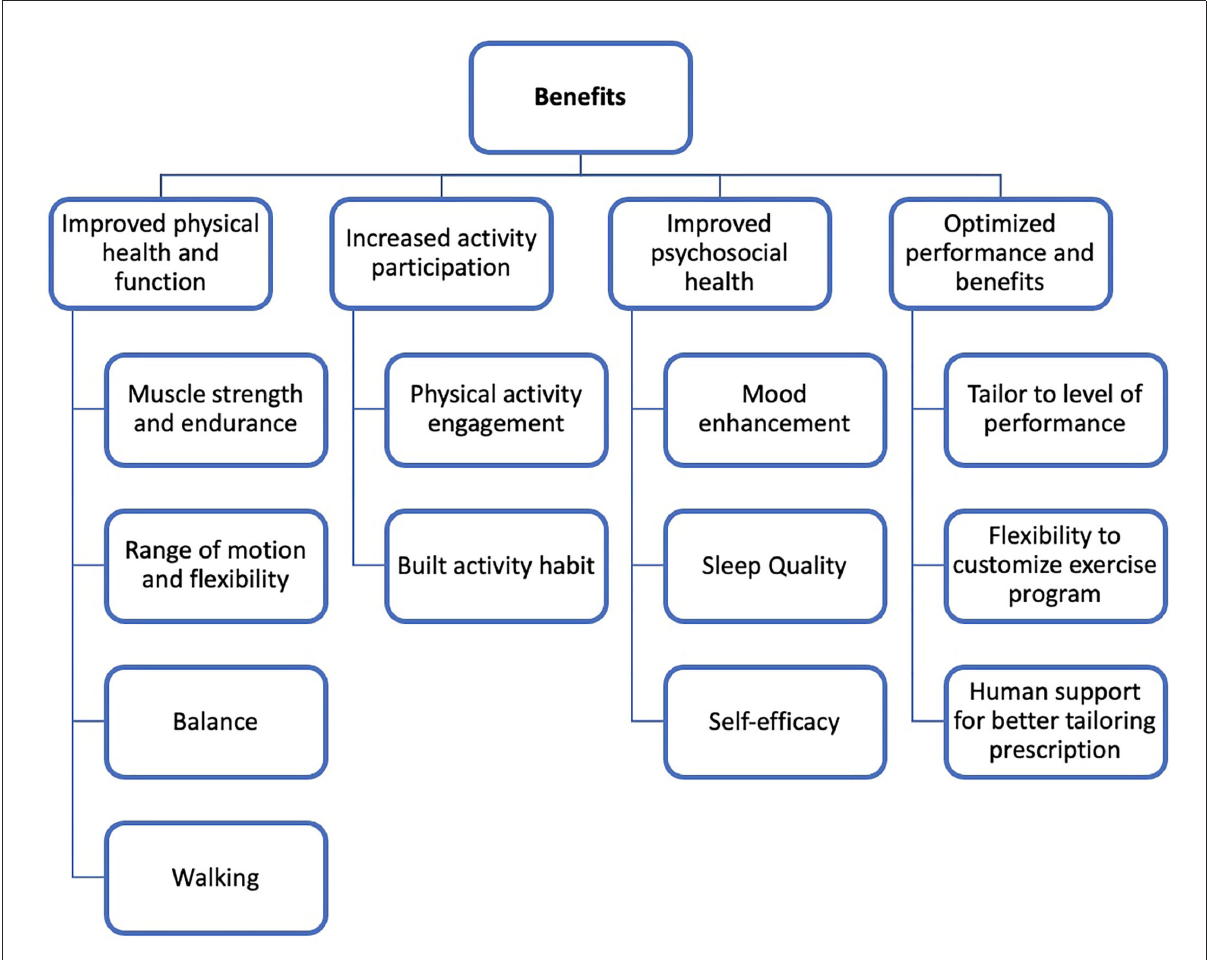
FIGURE1 Perceived benefits to SUPER-HEALTH among people with